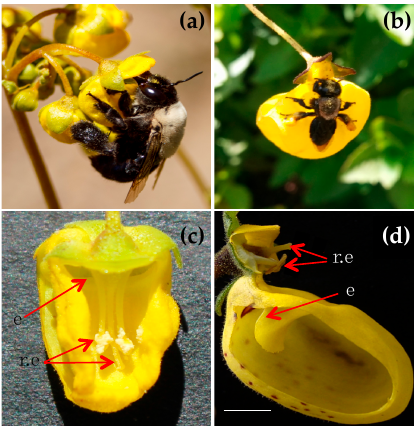
Figure 1. Oil-collecting bees and oil-secreting flowers. ( a ) Calceolaria cavanillesii and Centris chilensis , ( b ) Calceolaria filicaulis and Chalepogenus subcaeruleus , ( c ) aerial view of the lower lobe of C. cavanillesii and ( d ) lateral view of C. filicaulis . The arrows indicate the position of the reproductive structure (r.e) and elaiophore (e) in plant each species. The white bar represents the scale of 0.3 mm.